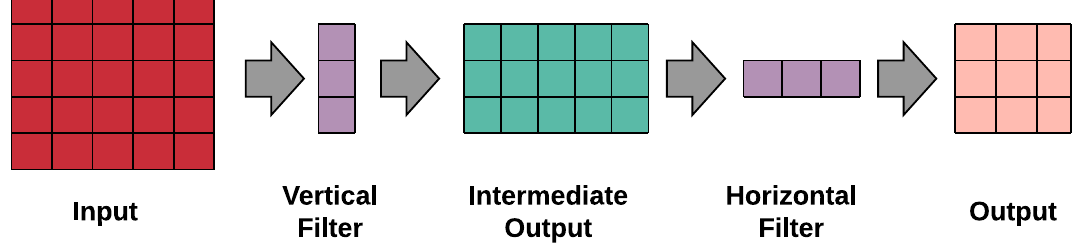
Figure 7. Graphic description of the Spatial separable convolution.